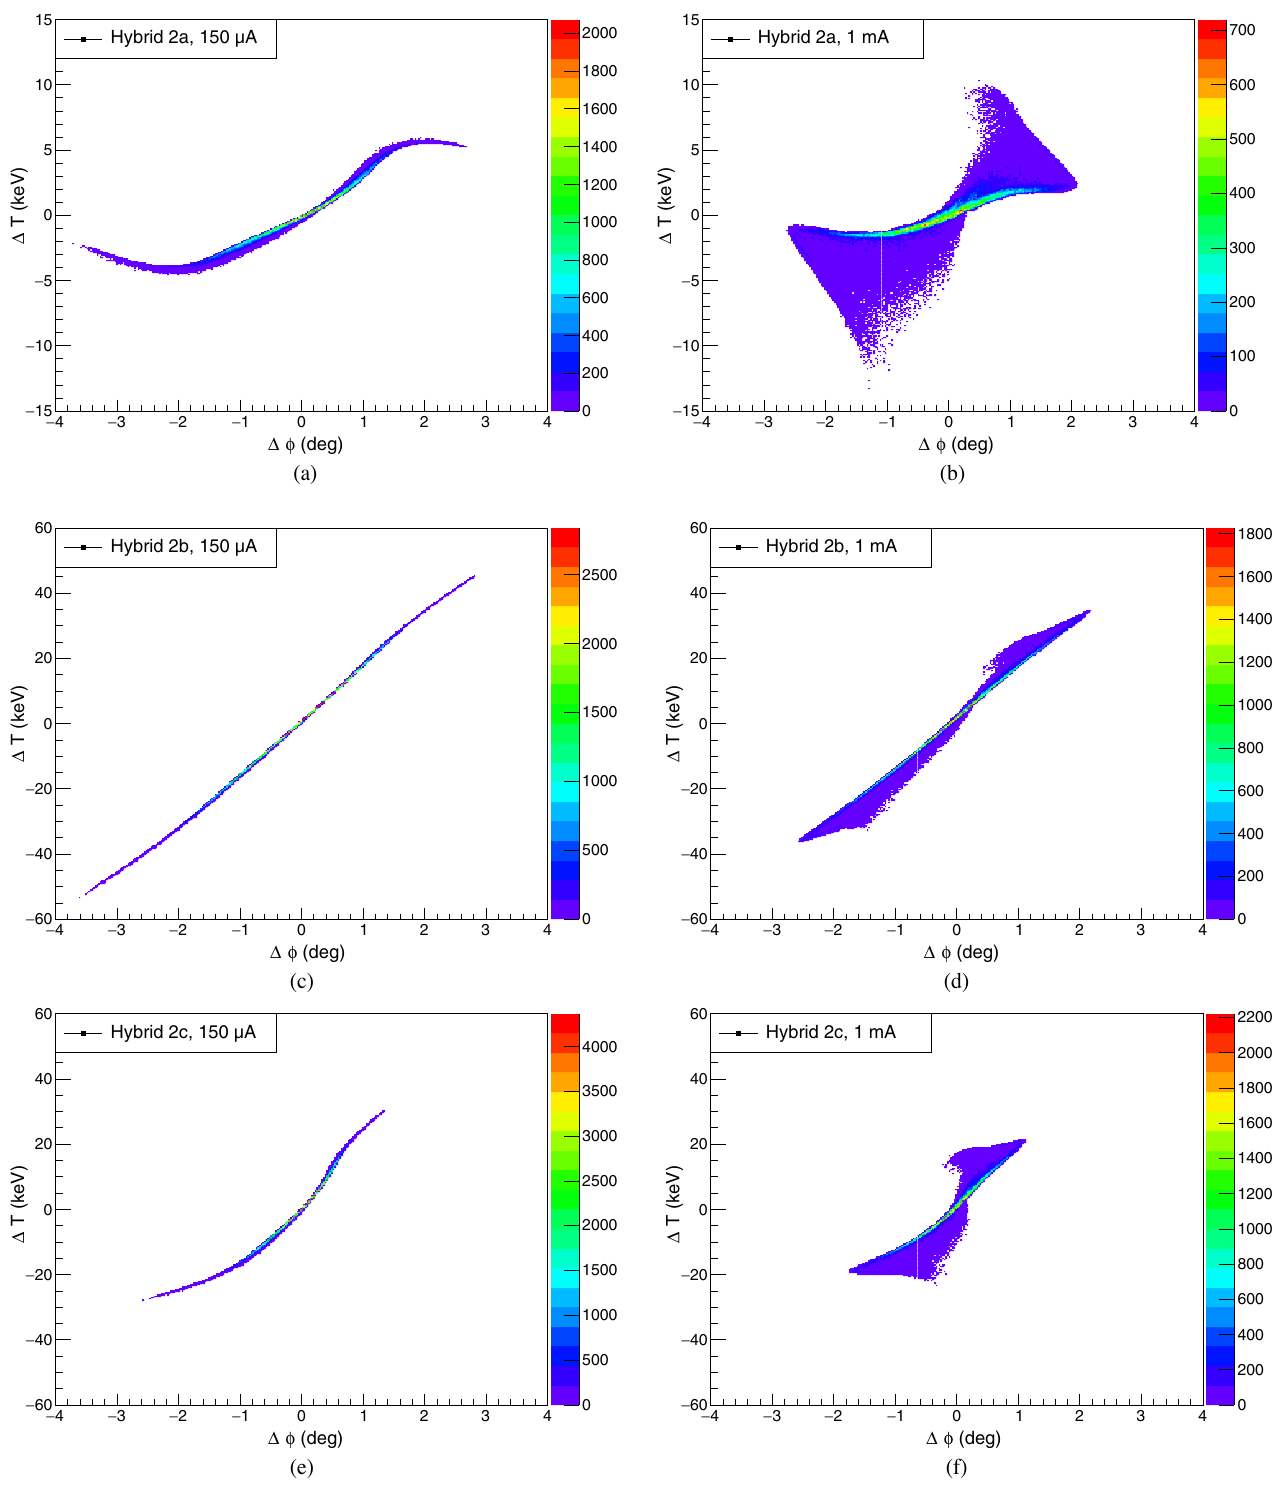
¼ 150 μ A (Figs. 8a, 8c and 8e) and b